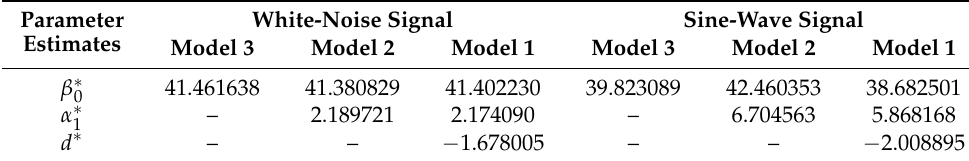
Table 8. Parameter estimates obtained by the LSOD method.